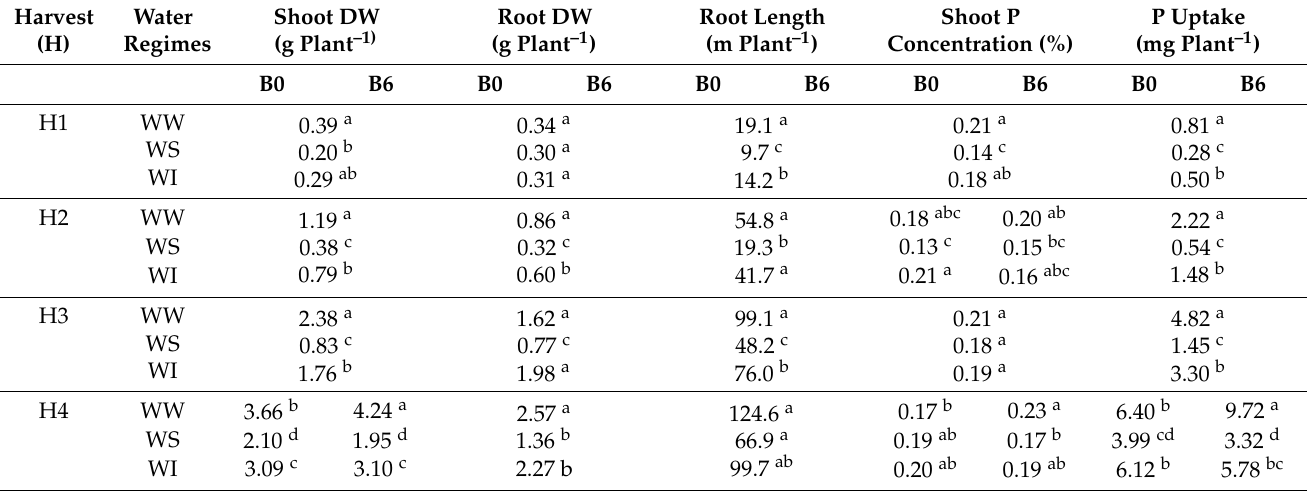
Table 3. Shoot and root dry weights, root length, shoot P concentration and P uptake per pot of subterranean clover for the well-watered (WW), water-stressed (WS) and water intermittently (WI) treatments at four harvest times with 6 t ha − 1 biochar (B6) or without application of biochar